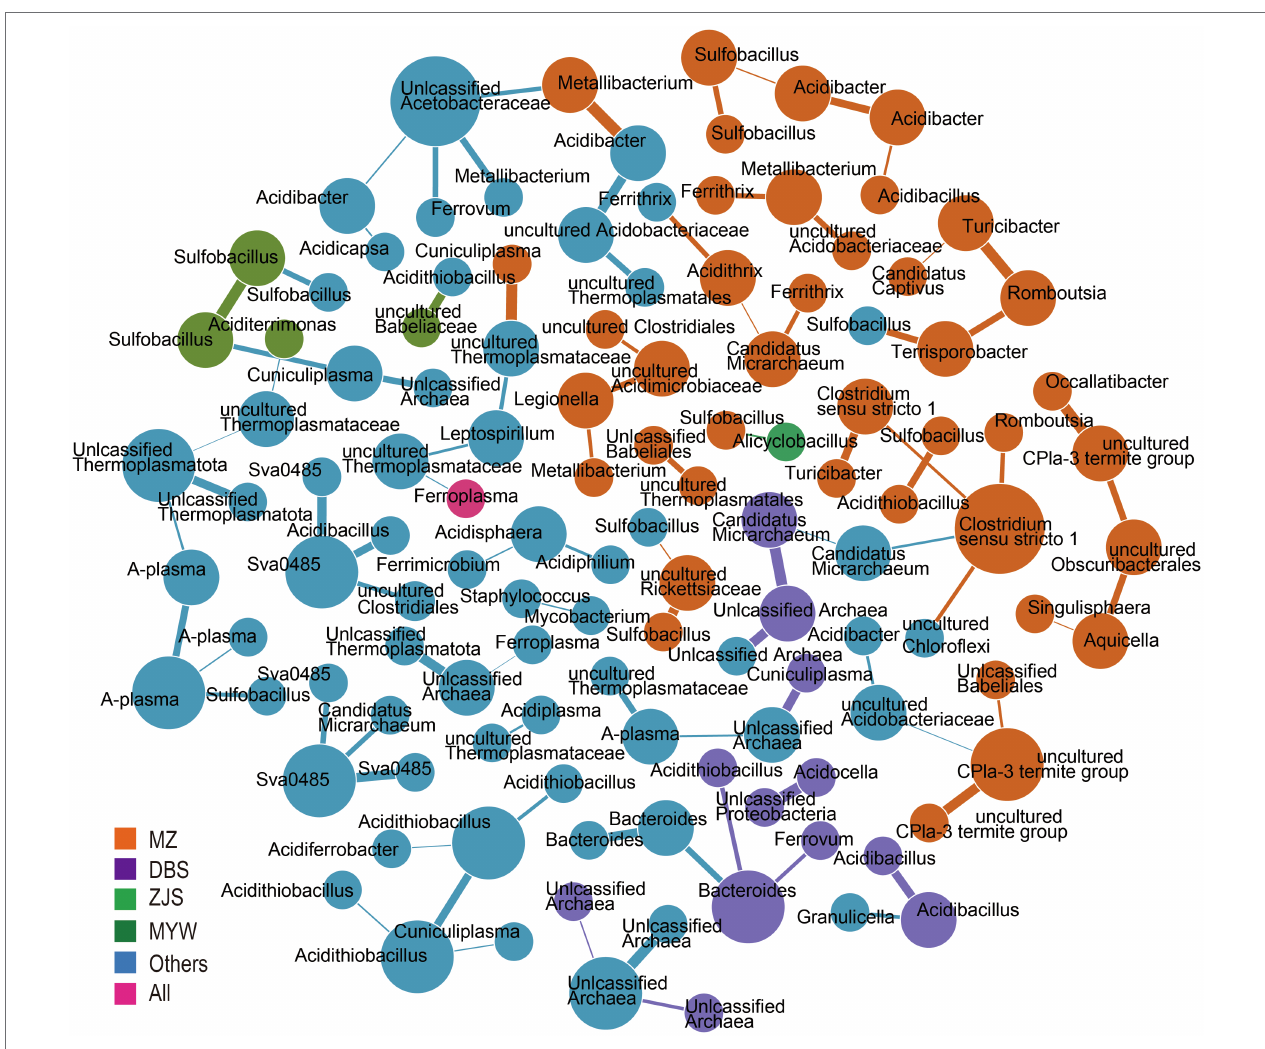
FIGURE 4 | Co-occurrence network analysis. Colors represent prevalence patterns of nodes. mining area (MZ), Dabaoshan (DBS), Monywa (MYW), and Zijinshan (ZJS) mean nodes occurred exclusively in that mining area. All represented nodes are presented in all mining